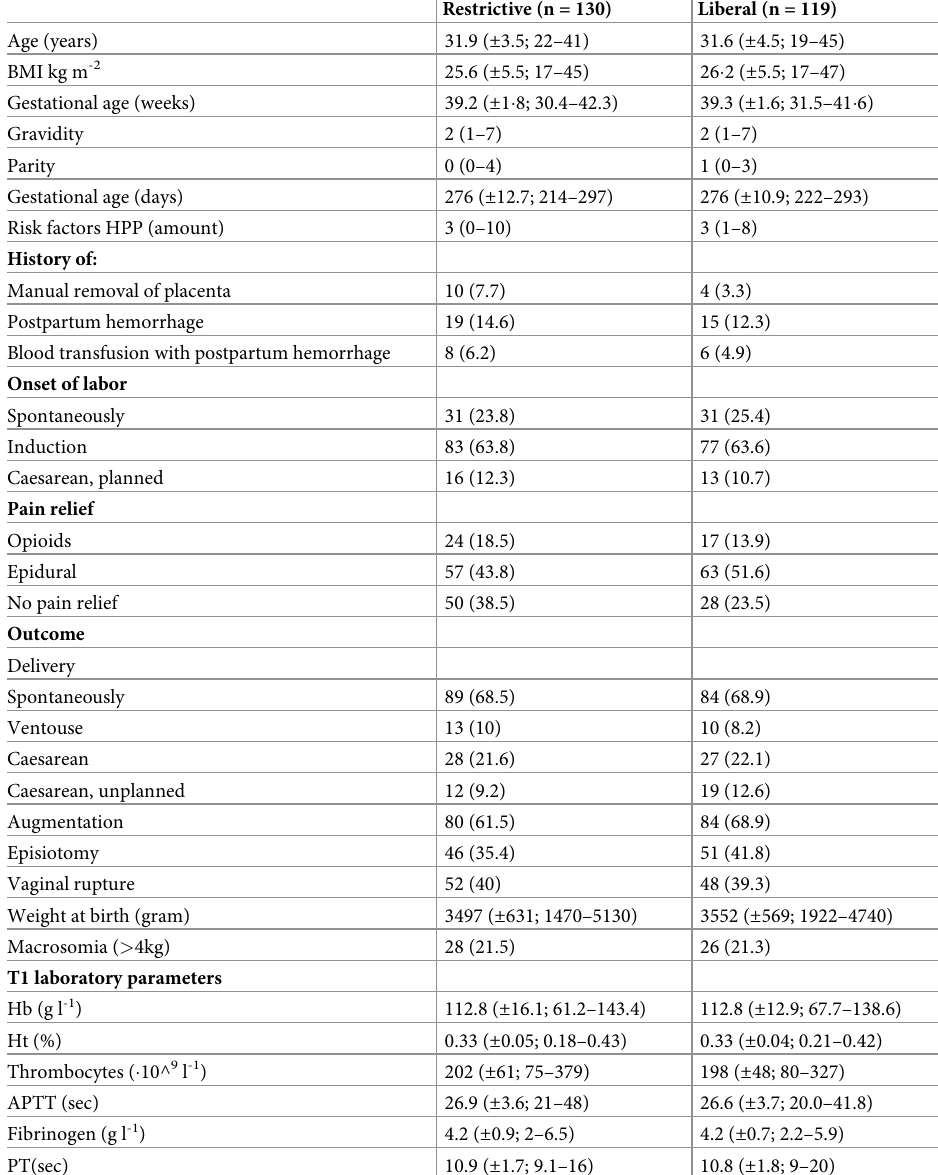
Table 1. Baseline